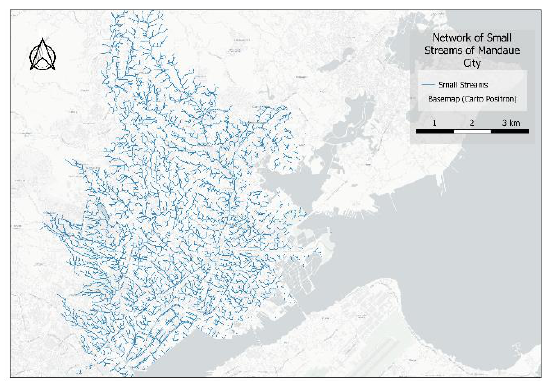
Figure 6. Network of small streams